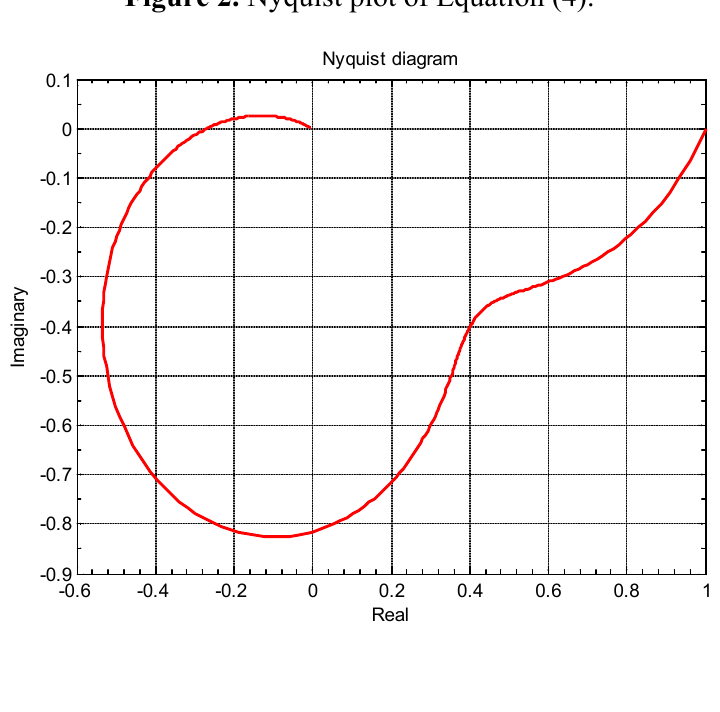
Figure 2. Nyquist plot of Equation